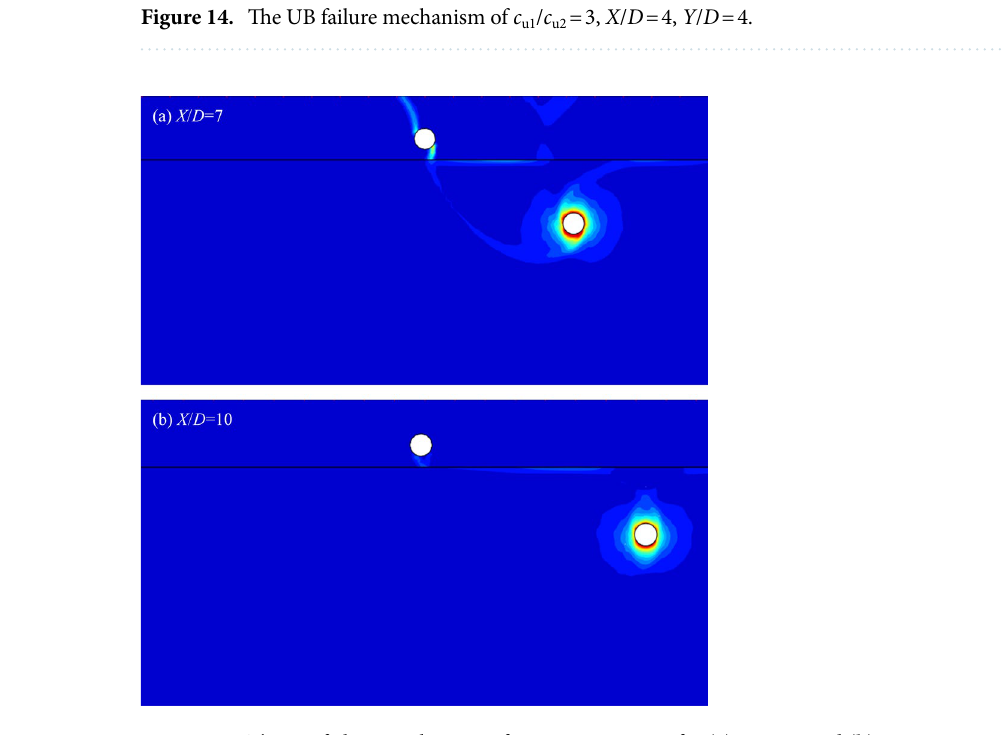
Figure 15. The UB failure mechanism of c u1 / c u2 = 3, Y / D = 4 for ( a ) X / D = 7 and ( b ) X / D =